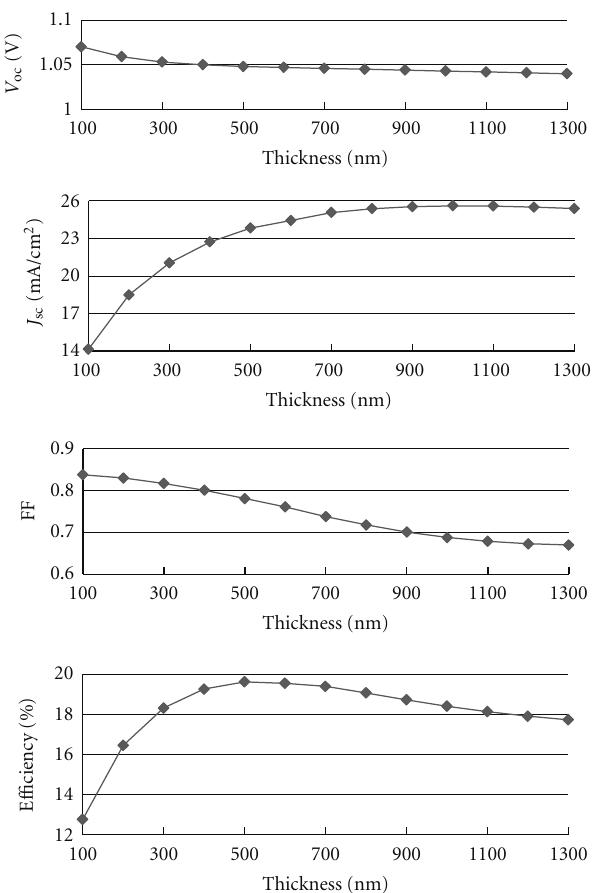
Figure 2: Photovoltaic characteristics for various absorber layer (a- Si:H) thickness.